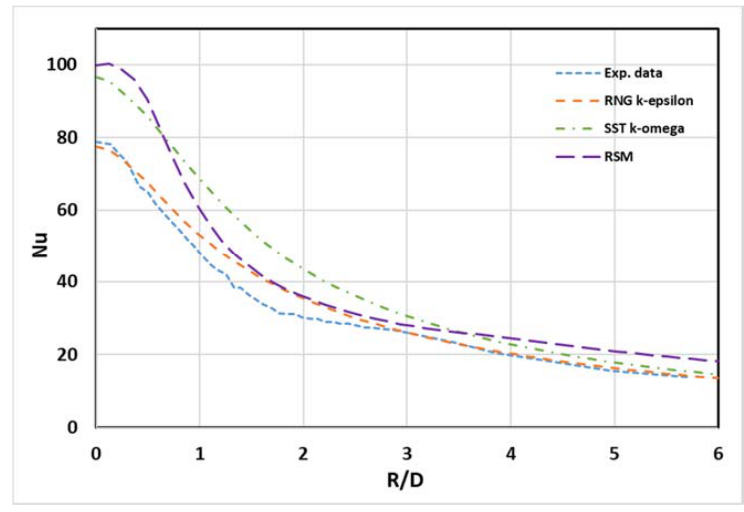
Figure 5. Turbulence model study. H/D = 6, R e = 10,000.